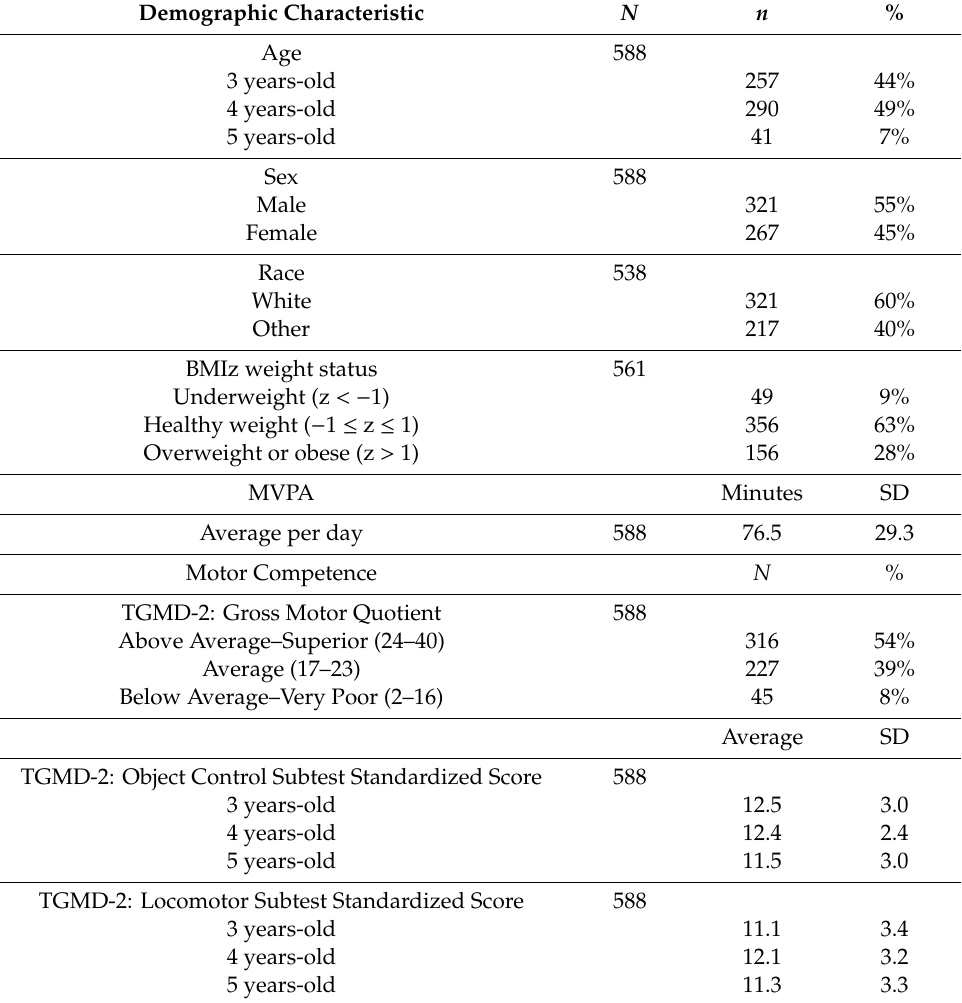
Table 1. Descriptive characteristics of CHAMP participants with physical activity and gross motor development measures ( N = 588) a